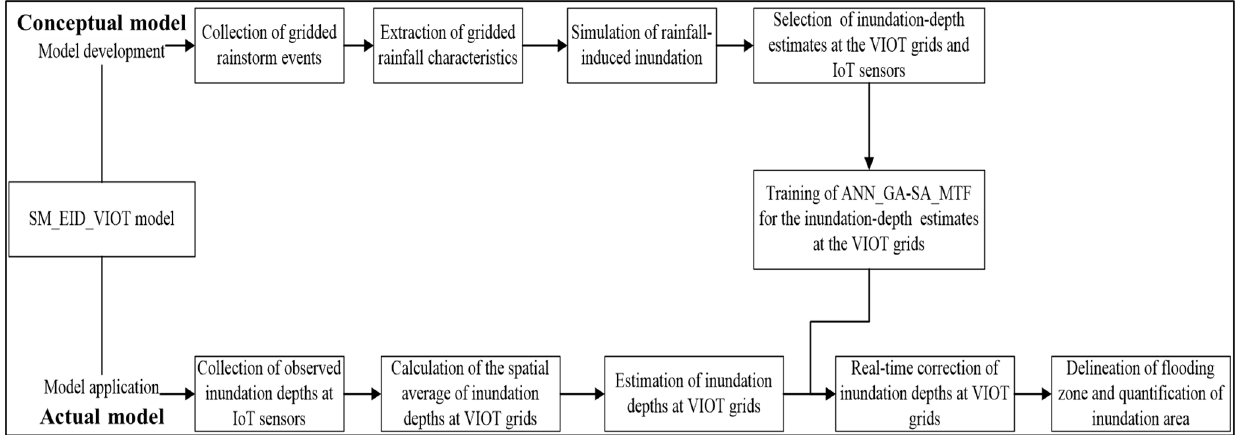
Figure 4. The framework for the development and application of the proposed SM_EDI_VIOT